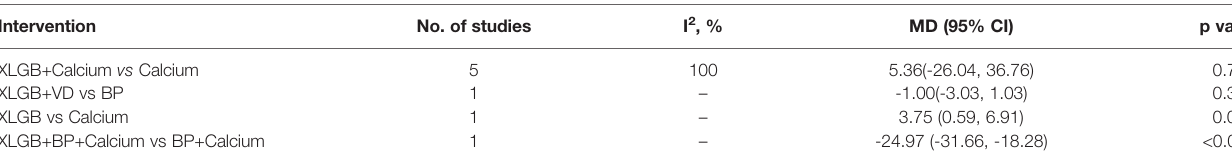
TABLE 5 | Traditional Meta-analysis of ALP.